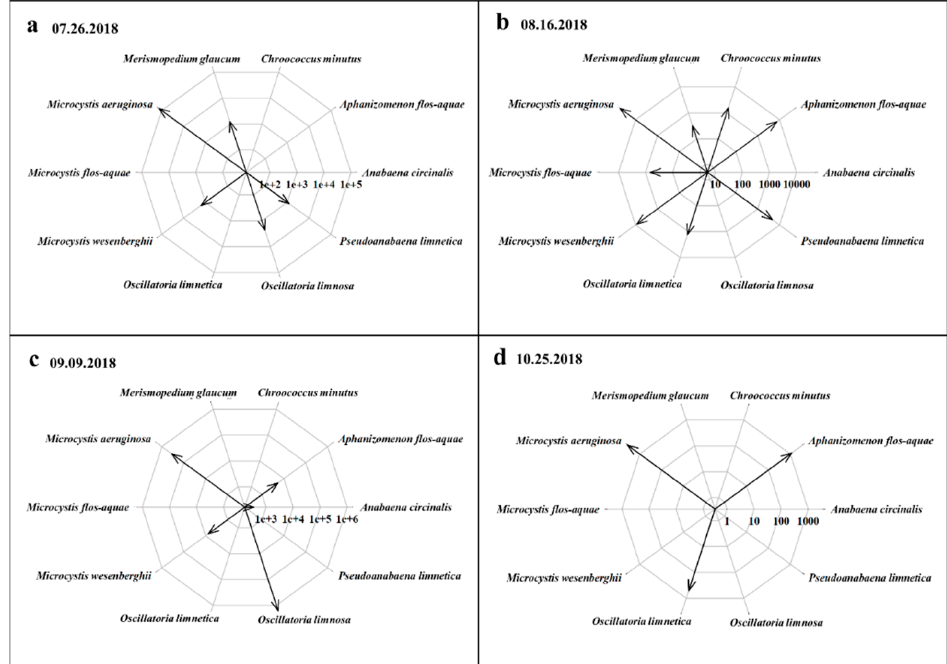
Figure 8. Radar plot of cyanobacteria cell composition with backscattering coefficient values at 550 nm for 2018—( a ) is the cell composition on 26 July; ( b ) is the composition on 16 August; ( c ) is the composition on 9 September; and ( d ) is the composition on 25 October. The black arrow indicates the concentration of cyanobacteria genus cells; the unit of concentration is cells mL − 1 .